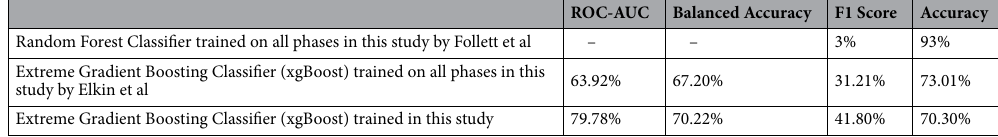
Table 5. Evaluation metric scores for state-of-the-art trial termination prediction models vs ours. Follett et al. used a random forest model trained on study characteristics features and features generated by text mining of study descriptions 9 . Elkin et al. used an xgBoost model trained on study characteristics features and document embedding vector features 10 . In this research we used an xgBoost model trained on study